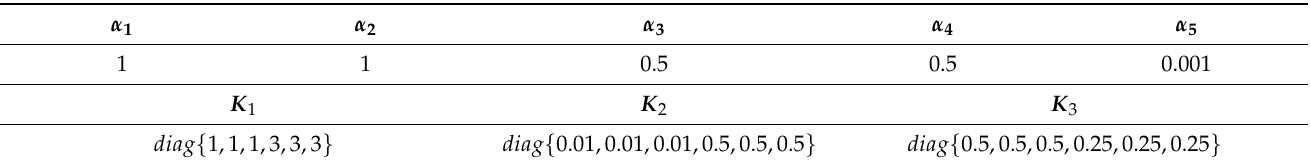
Table 1. The control parameters of APISM-FTC